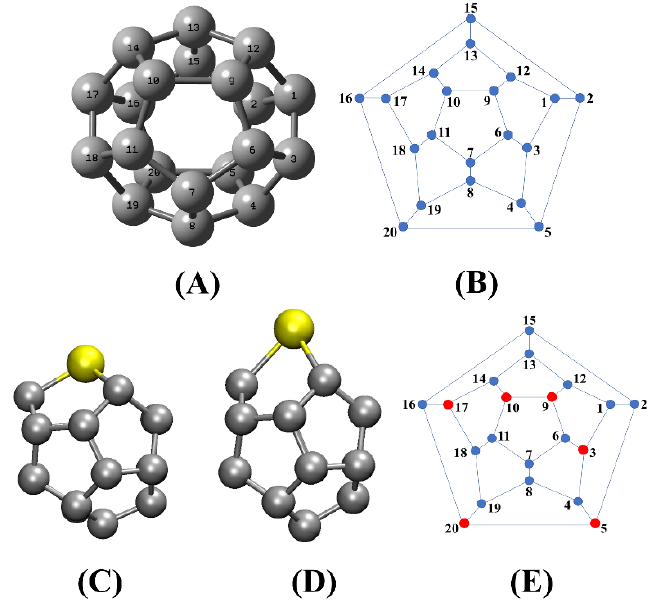
Figure 2. ( A ) C 20 fullerene structure and ( B ) its corresponding Schlegel diagram. The atom indexes are presented to elucidate the Si doping positions. ( C ) represents the substitutions which produced the set C 19 Si ( A ) formed by: C 19 Si (1), C 19 Si (2), C 19 Si (4), C 19 Si (6), C 19 Si (7), C 19 Si (8), C 19 Si (11), C 19 Si (12), C 19 Si (13), C 19 Si (14), C 19 Si (15), C 19 Si (16), C 19 Si (18) and C 19 Si (19). ( D ) represents the substitutions which produced the set C 19 Si ( B ) formed by: C 19 Si (3), C 19 Si (5), C 19 Si (9), C 19 Si (10), C 19 Si (17) and C 19 Si (20). ( E ) In the Schlegel diagram, the blue dots represent the position of the heteroatoms that resulted in geometrical conformers with the characteristics shown in C 19 Si ( A ). The red dots indicate the positions of the heteroatoms that resulted in geometrical conformers with the characteristics shown in C 19 Si ( B ).